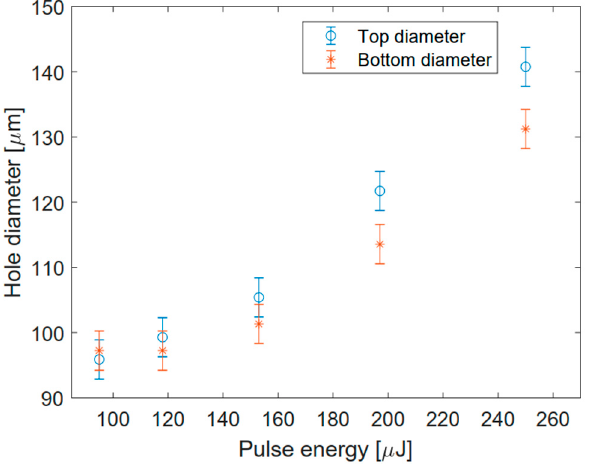
Figure 3. Dependence of the hole diameter on the BB pulse energy in the case of a 200 µ m thick AF32 glass sample drilled in one machining pass with 60 writing circles. Energy and diameter values correspond to the images of Figure 2.